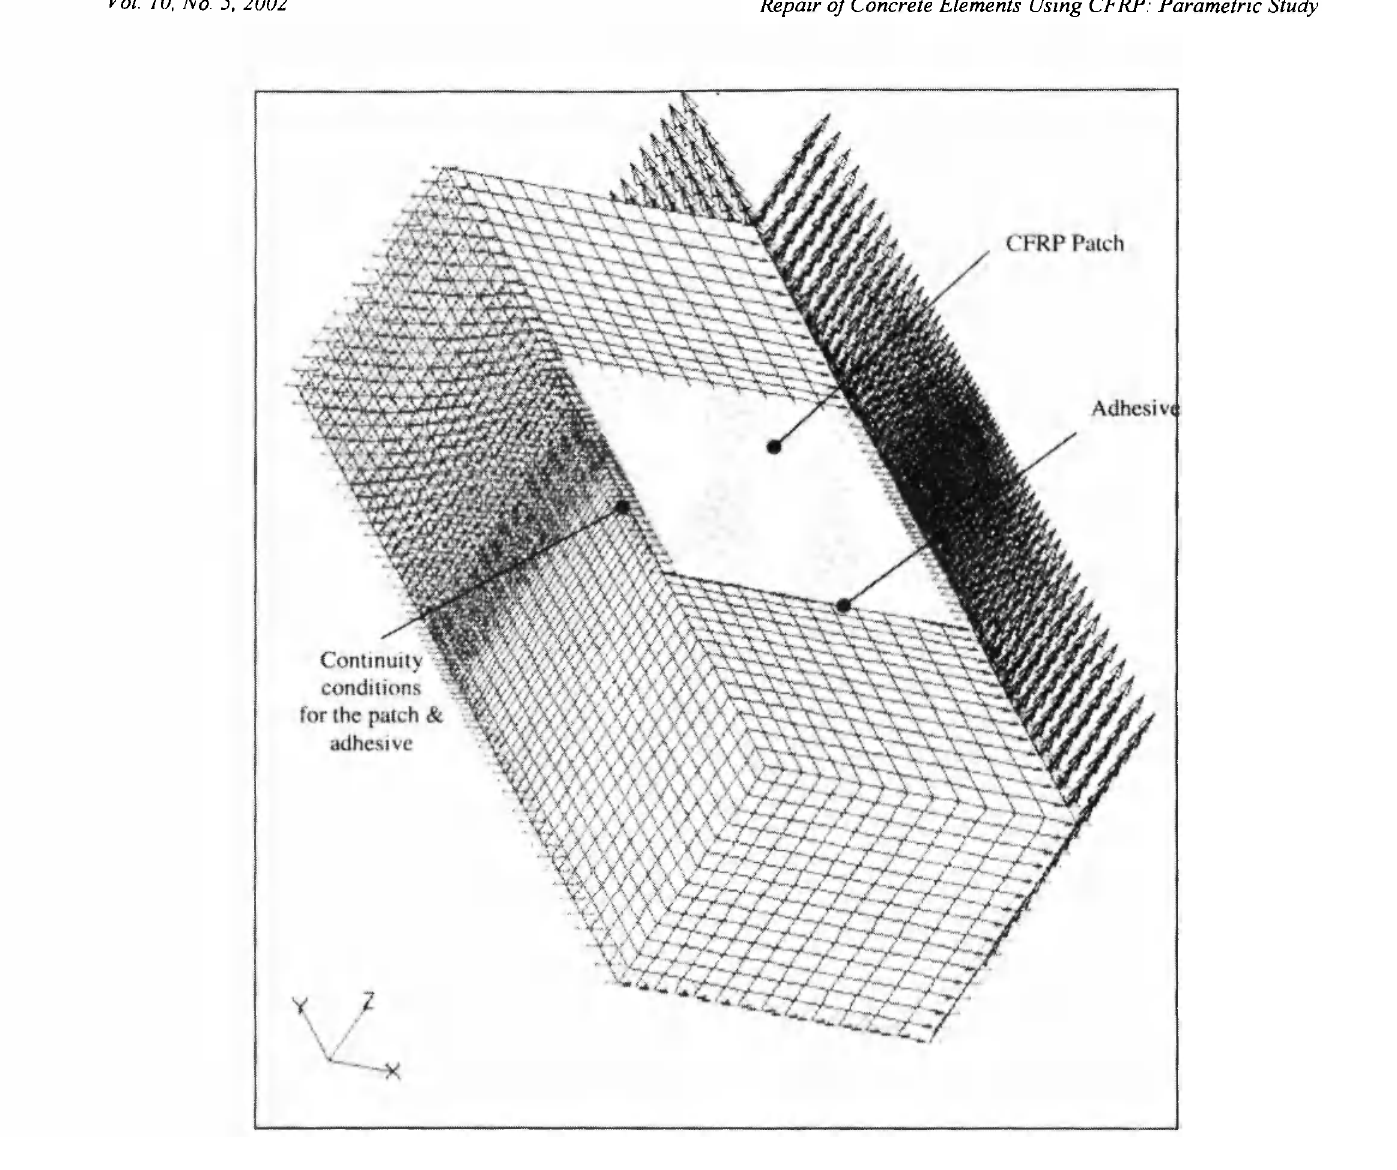
Fig. 3: FEM model (3D-B) for the analysis of the repaired concrete beam. Two lateral CFRP patches have been used.